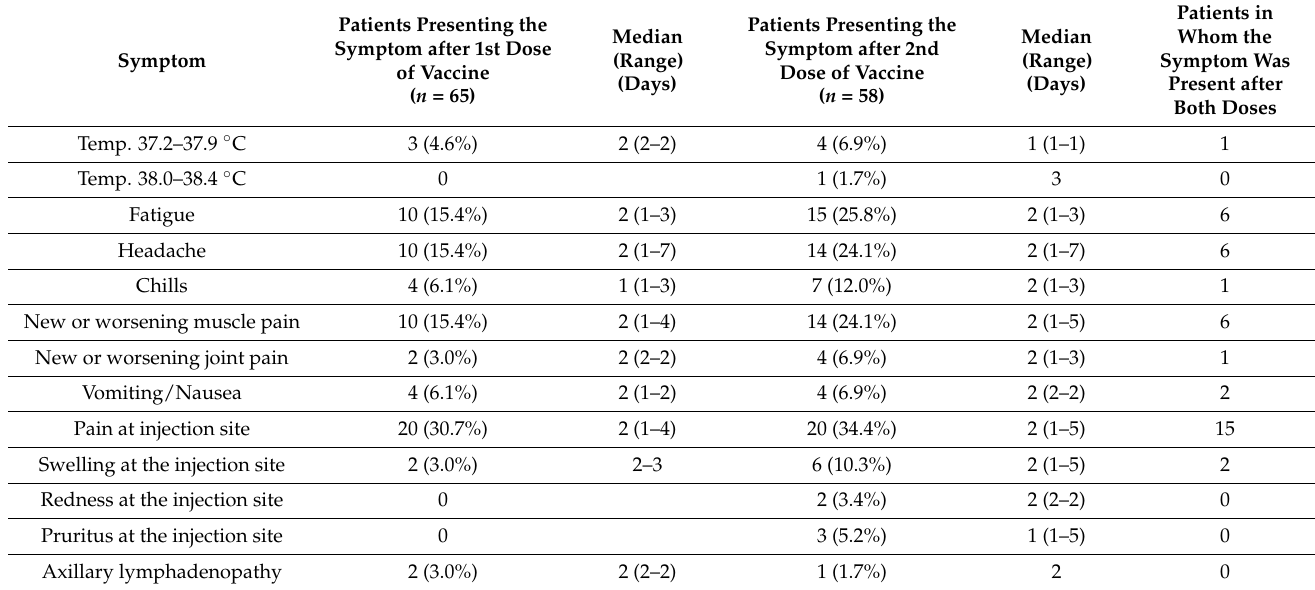
Table 2. Adverse events after each vaccine